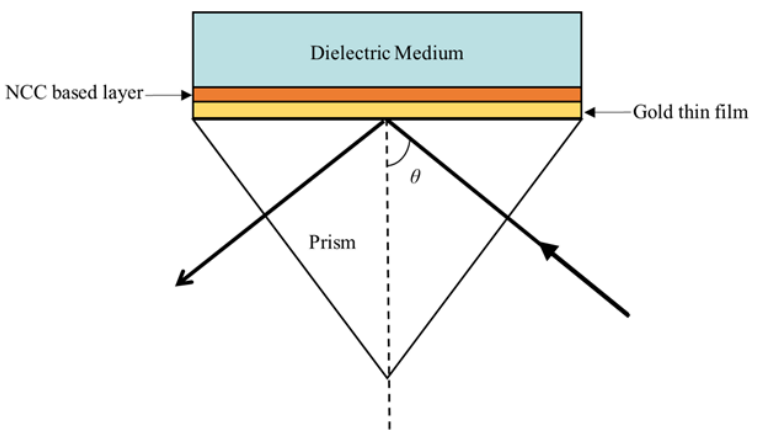
Figure 1. Kretschmann configuration to generate the surface plasmon resonance (SPR) signal.